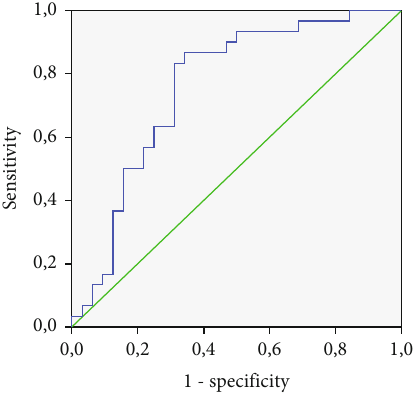
Figure 3: NT-proBNP level and HFpEF incidence.